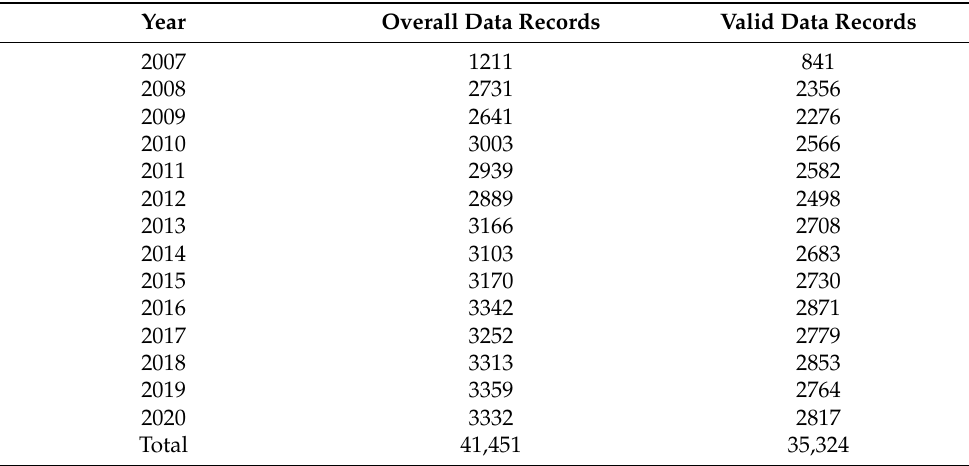
Table 3. Number of inspection records of reinforced concrete main girders